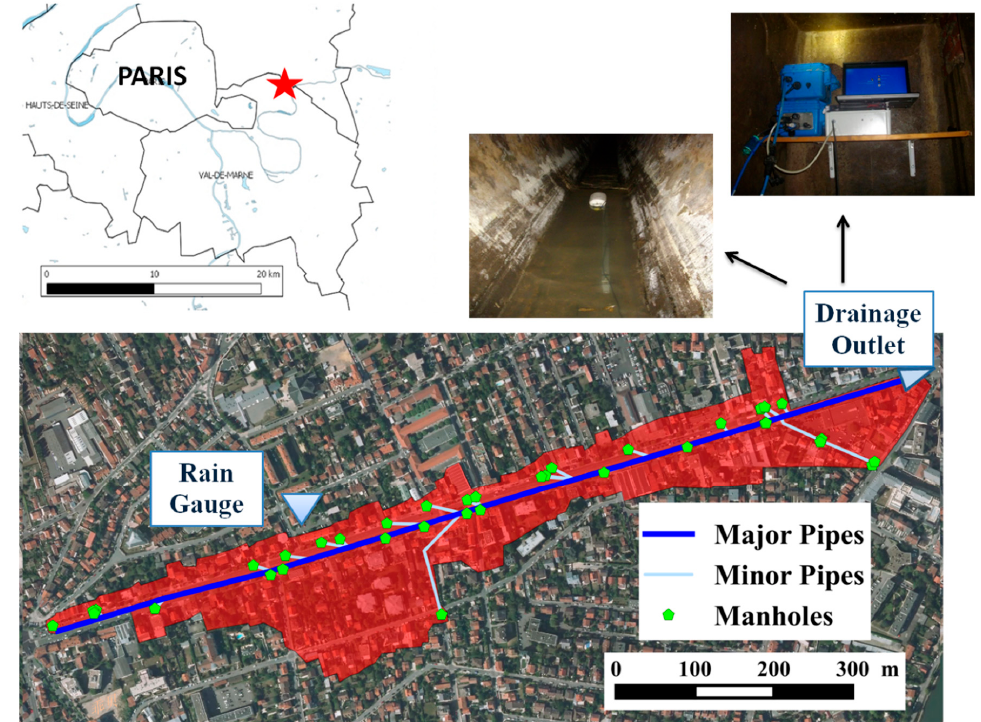
Figure 2. Study urban catchment in eastern Paris (12 ha, Le Perreux sur Marne, France). A rain gauge